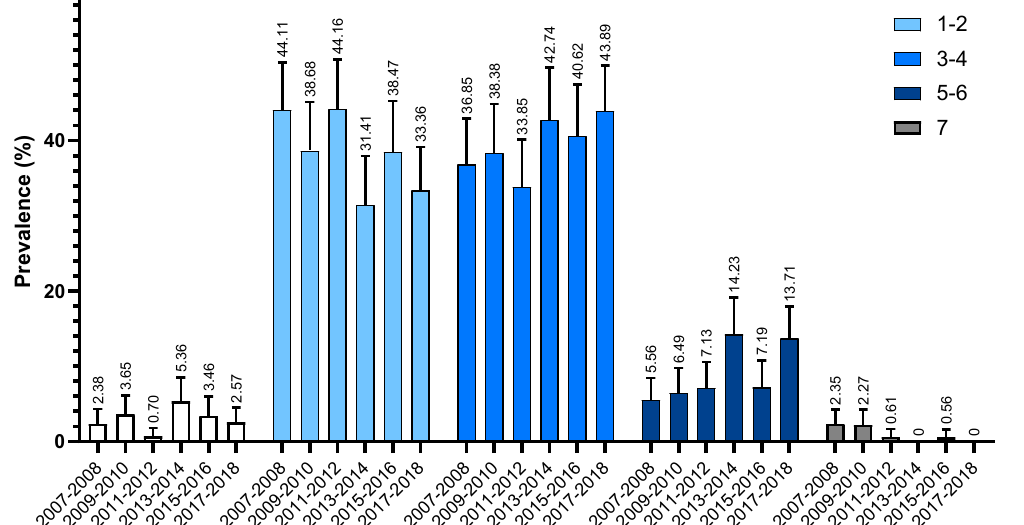
Figure 3. Trends in the Number of Unhealthy Lifestyle Behaviors among U.S. Adults with a History of Stroke, 2007–2018. The total unhealthy lifestyle score for each participant was the number of all unhealthy lifestyle risk factor. The total unhealthy lifestyle score was grouped in 5 groups as “0 = Ideal”, “1–2 = Good”, “3–4= Intermediate”, “5–6 = Poor”, “7 = Extremely poor”.